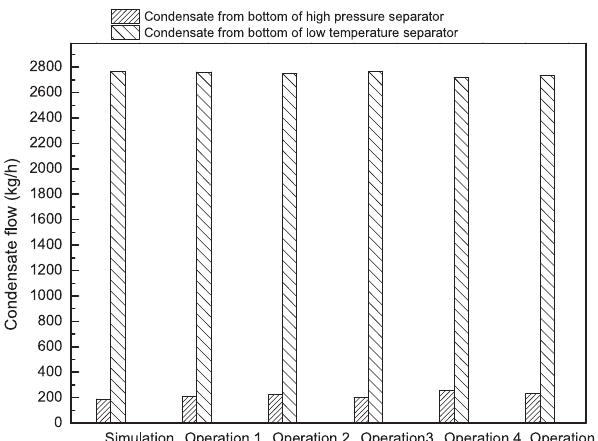
Fig. 16. The comparison of condensate between simulation and